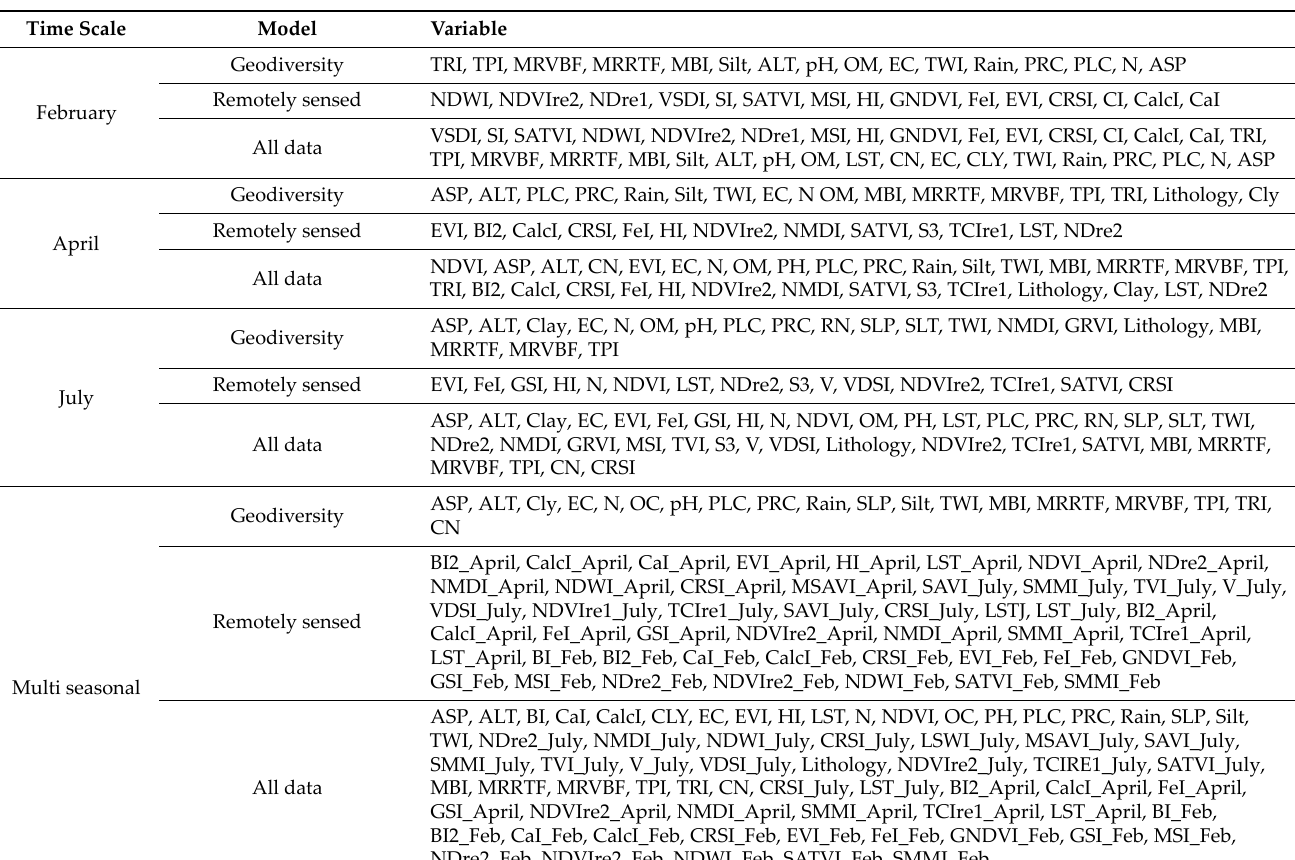
Table A1. Selected variables for modeling plant diversity in single‑date and multi‑seasonal models for each time milestone (February, April, and